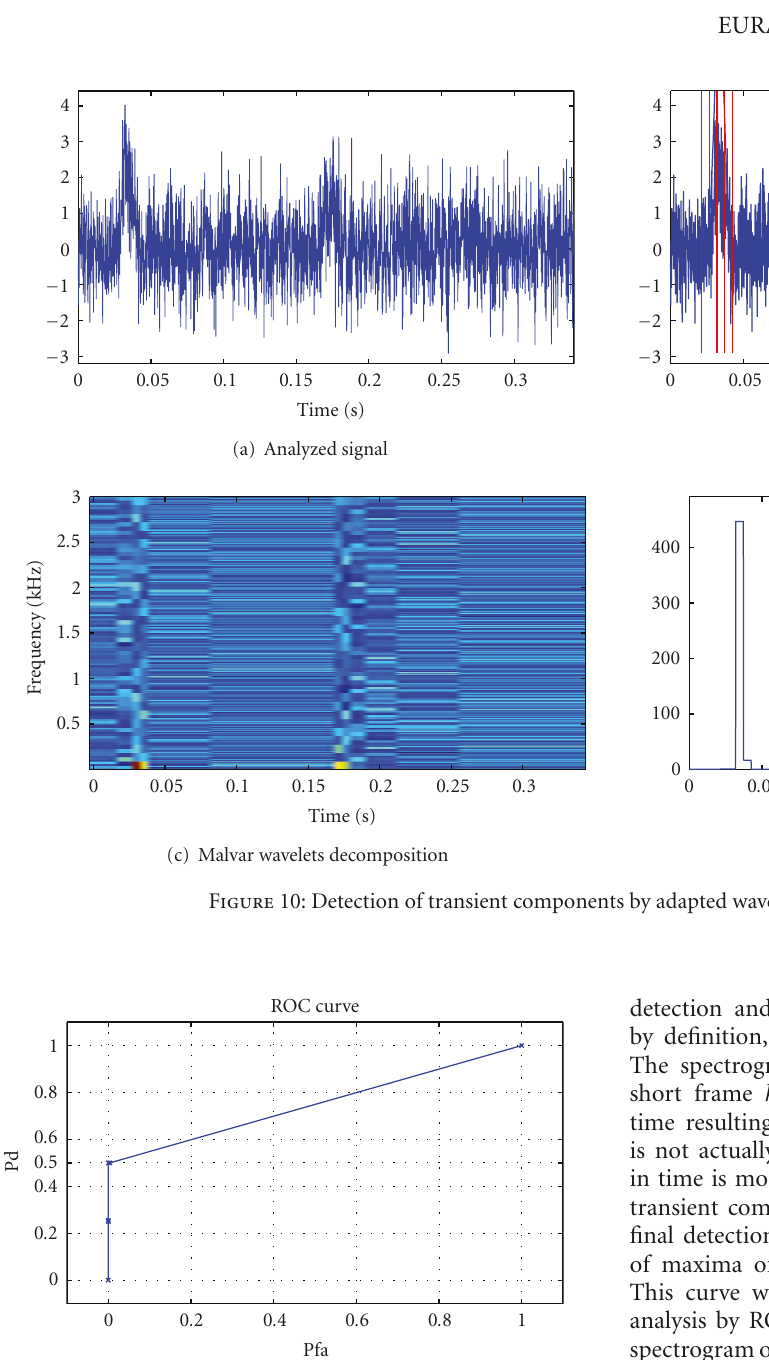
Figure 11: ROC curve for detection based on Malvar wavelet adapted